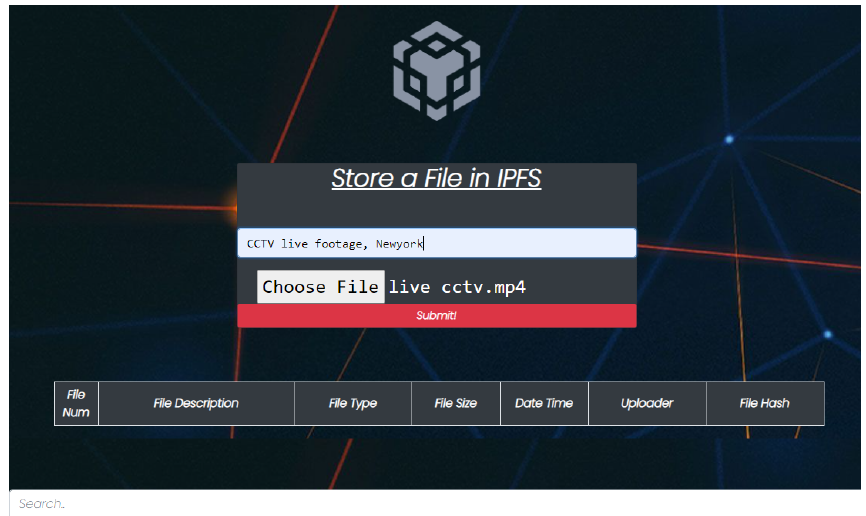
Figure 21. No event log listed on the DApp.